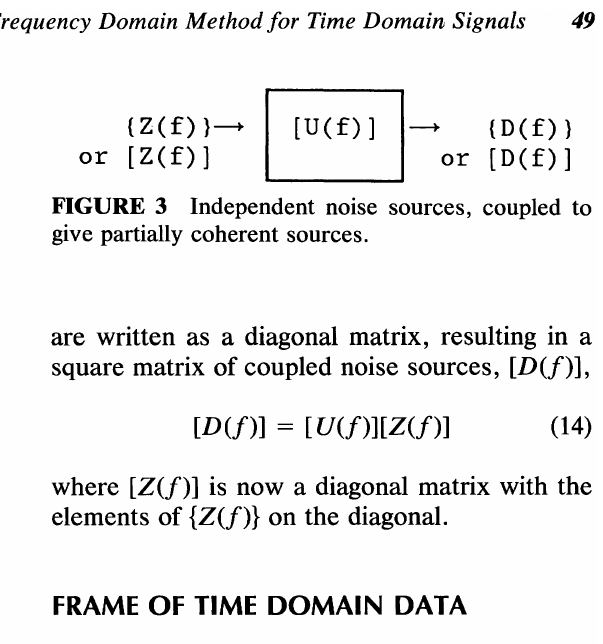
FIGURE 3 Independent noise sources, coupled to give partially coherent